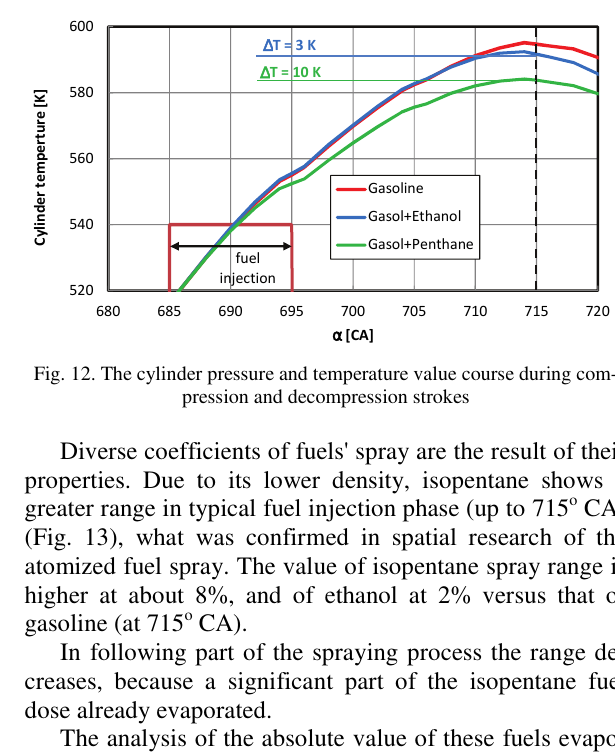
Fig. 11. The development of the gasoline (red spheres) and iso-pentane (green spheres) streams in the two-injectors system (combustion chamber section concerns the 1/ l quantity